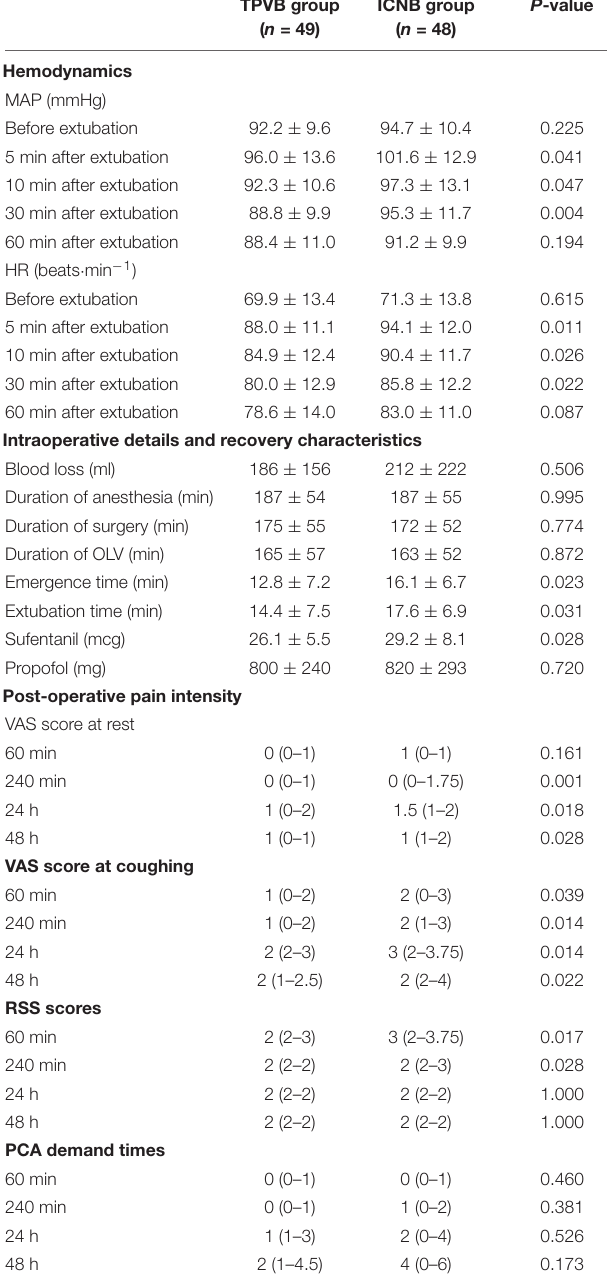
TABLE 1 | Clinical characteristics of the patients.